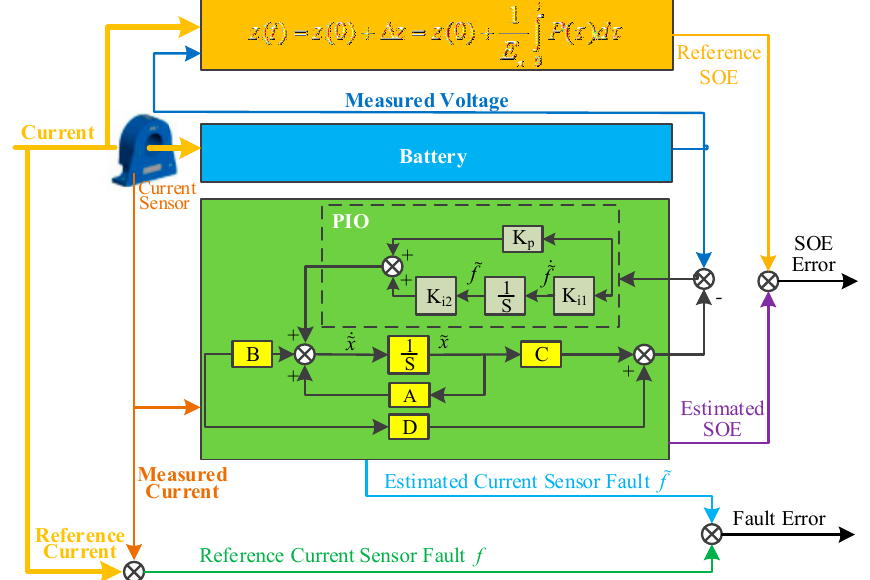
Figure 2. The method to simultaneously detect the current sensor fault and estimate the SOE.